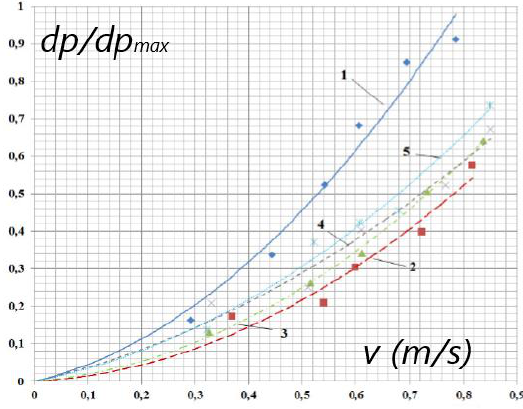
Fig. 12 Pressure difference ratio for different types of